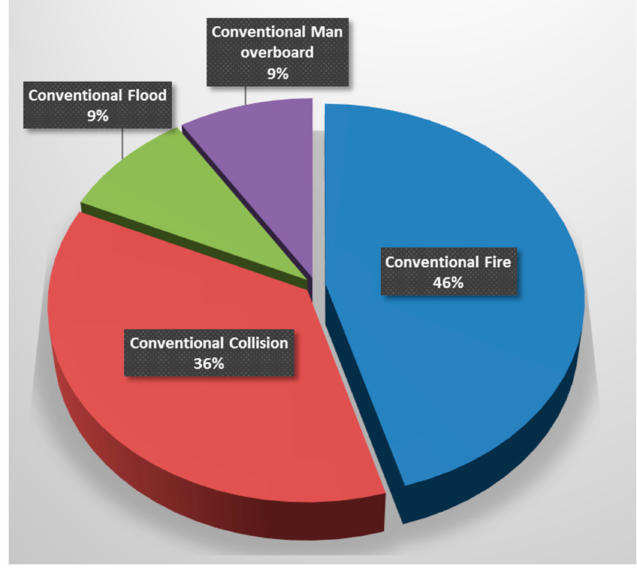
Figure 3. Relative Contribution of Conventional Submarine Incident Types,